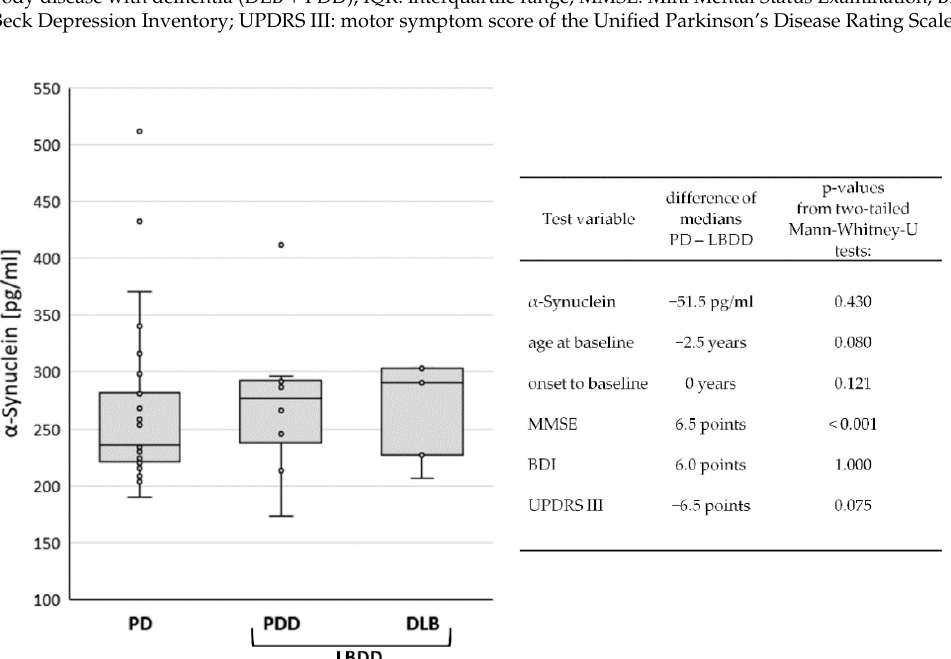
PD: Parkinson’s disease ; PDD: Parkinson’s disease dementia; DLB: dementia with Lewy bodies; LBDD: Lewy body disease with dementia (DLB + PDD); IQR: interquartile range; MMSE: Mini Men-